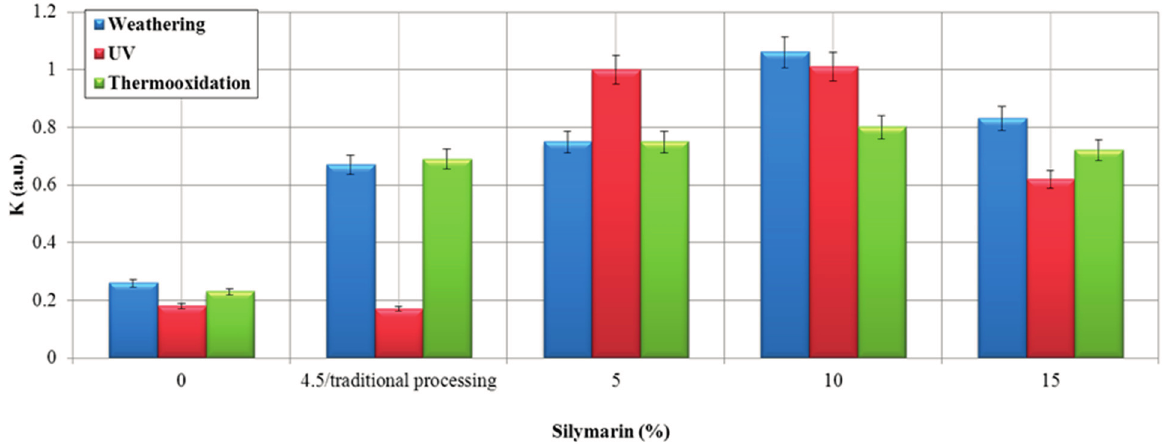
Figure 3. Ageing coefficient of EPM composite modified with the addition of silymarin via the impregnation